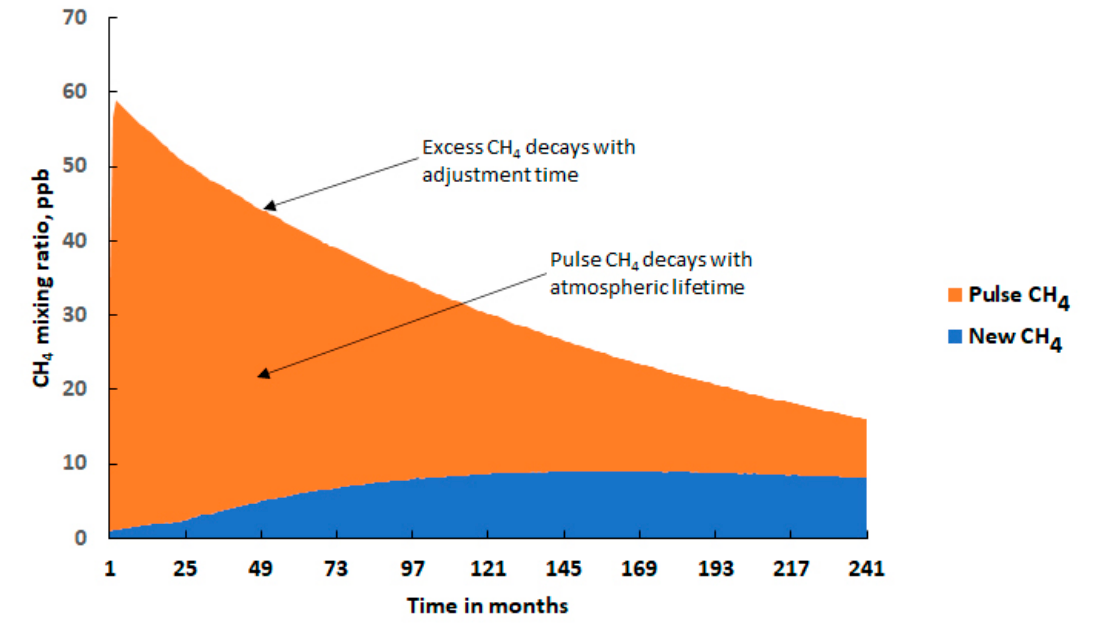
Figure 1. Time development of the excess global mean CH 4 mixing ratio following the addition of a 149 Tg CH 4 emission pulse, showing the ‘excess’ CH 4 = ‘pulse’ CH 4 + ‘new’ CH 4 as the upper curve, the pulse CH 4 (red area) and new CH 4 (blue area), based on a similar figure taken from ref.